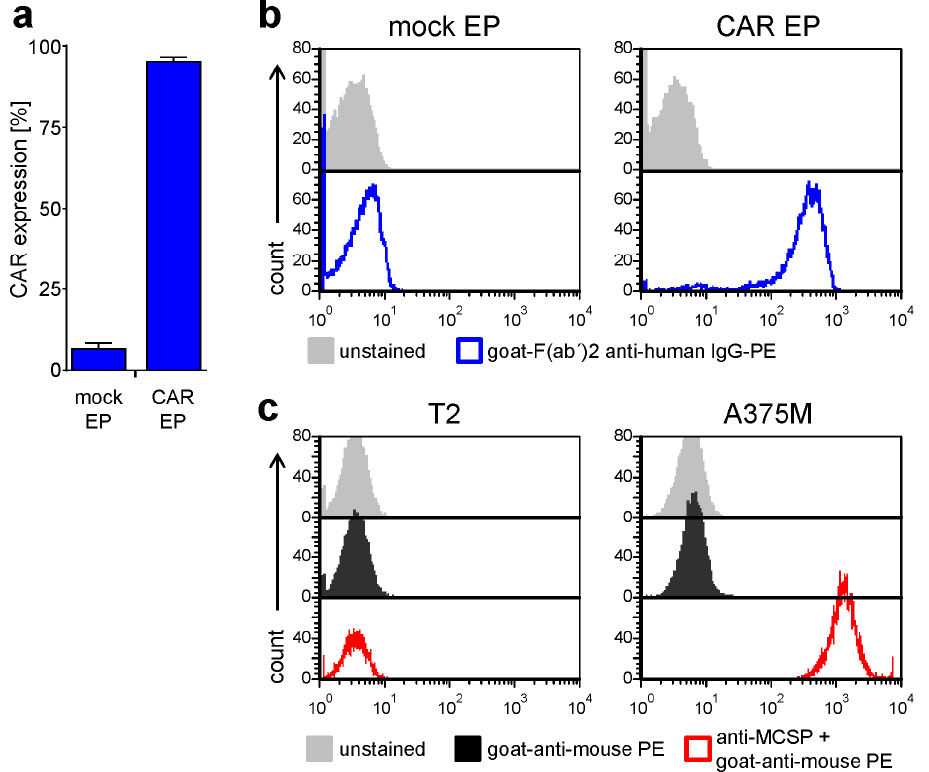
Figure 1. CSPG4-specific CAR and CSPG4 expression on effector T cells and target cells, respectively. ( a , b ) Peripheral blood mononuclear cells (PBMCs) were isolated from the blood of healthy donors through density gradient centrifugation and CD8 + T cells were isolated with magnetic activated cell sorting (MACS) beads. These cells were either mock electroporated (EP) or were transfected with RNA encoding the CSPG4-specific CAR. CAR expression was flow-cytometrically determined 4 h after electroporation by staining with a PE-labeled goat-F(ab ′ )2 anti-human IgG antibody. ( a ) Percentage of CAR-positive cells (average of 8 independent experiments +SEM; original data see Table S1) and ( b ) Histograms of one typical experiment (grey histograms: unstained cells, and blue histograms: goat-F(ab ′ )2 anti-human IgG-PE stained cells) are shown. ( c ) The CSPG4 antigen expression on the target cell lines T2 and A375M was determined by flow cytometry after primary staining with a CSPG4-specific antibody and secondary staining PE-labeled with goat-anti-mouse. Grey histograms: unstained cells; black histograms: secondary only staining; red histograms: primary anti-CSPG4 staining + secondary staining.